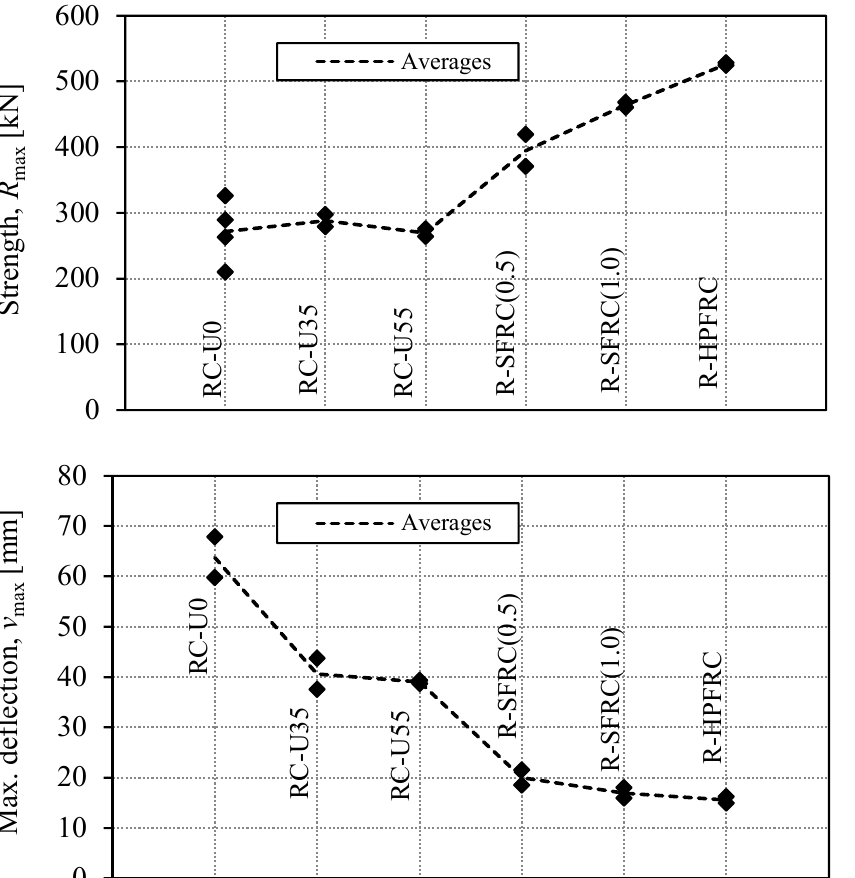
Figure 9. Comparison of results of the tests of the present paper and those from [12,22].